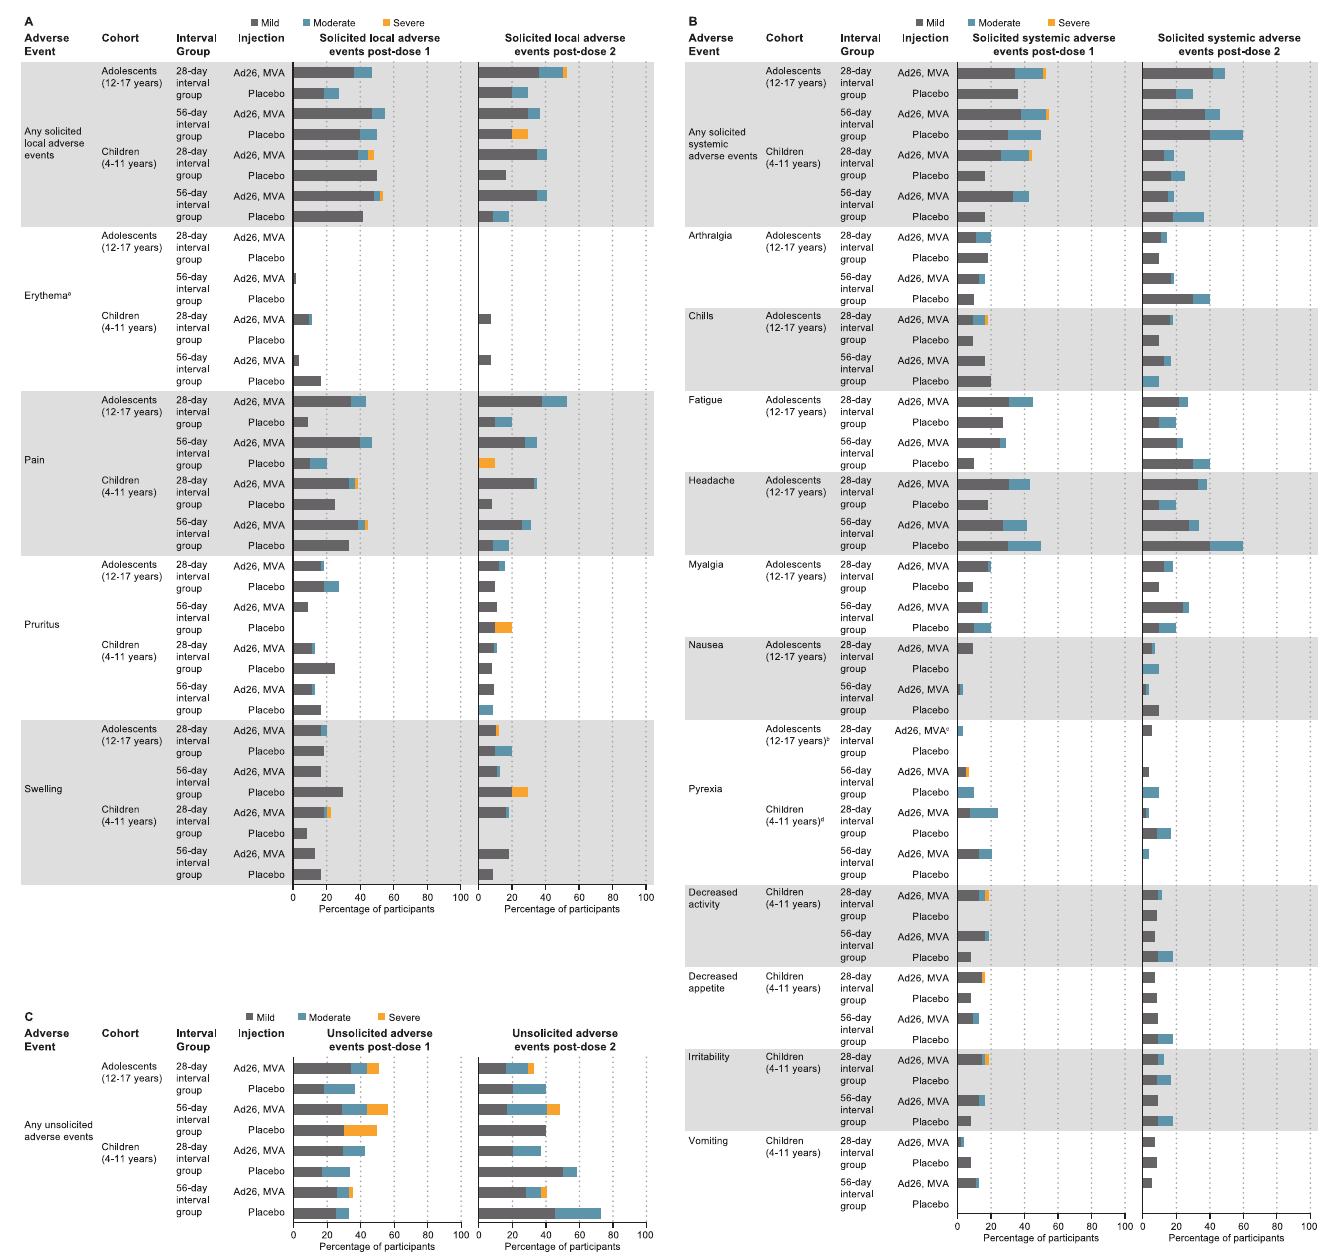
Fig 2. Solicited local AEs. ( A ) Solicited systemic AEs ( B ) and unsolicited AEs ( C ); full analysis set. Percentages reflect n / N where n is the number of participants with one or more AEs and N is the number of participants with available reactogenicity data after the given dose (solicited AEs) or the number of participants who received the given dose (unsolicited AEs). Only unsolicited AEs reported between the dose 1 vaccination and 28 days post-dose 1, and between dose 2 vaccination and 28 days post-dose 2 are included in this table. Different diaries were used in adolescents (12–17 years) and children (4–11 years) to collect solicited systemic AEs. Solicited systemic AEs collected in adolescents: arthralgia, chills, fatigue, headache, myalgia, nausea, and pyrexia; in children: pyrexia, decreased activity, decreased appetite, irritability, and vomiting. a Per the DMID Toxicity Tables used in this study, erythema was graded based on the diameter data only. b Pyrexia mild: 38.0–38.4 ˚C, moderate: 38.5–38.9 ˚C, severe: > 38.9 ˚C. c N = 54. d Pyrexia mild: 38.0–38.4 ˚C, moderate: 38.5–40.0 ˚C, severe: > 40.0 ˚C. Ad26: Ad26.ZEBOV at a dose of 5 × 10 10 viral particles; MVA: MVA-BN-Filo at a dose of 1 × 10 8 Inf.U. Ad26, Ad26.ZEBOV; AE, adverse event; DMID, Division of Microbiology